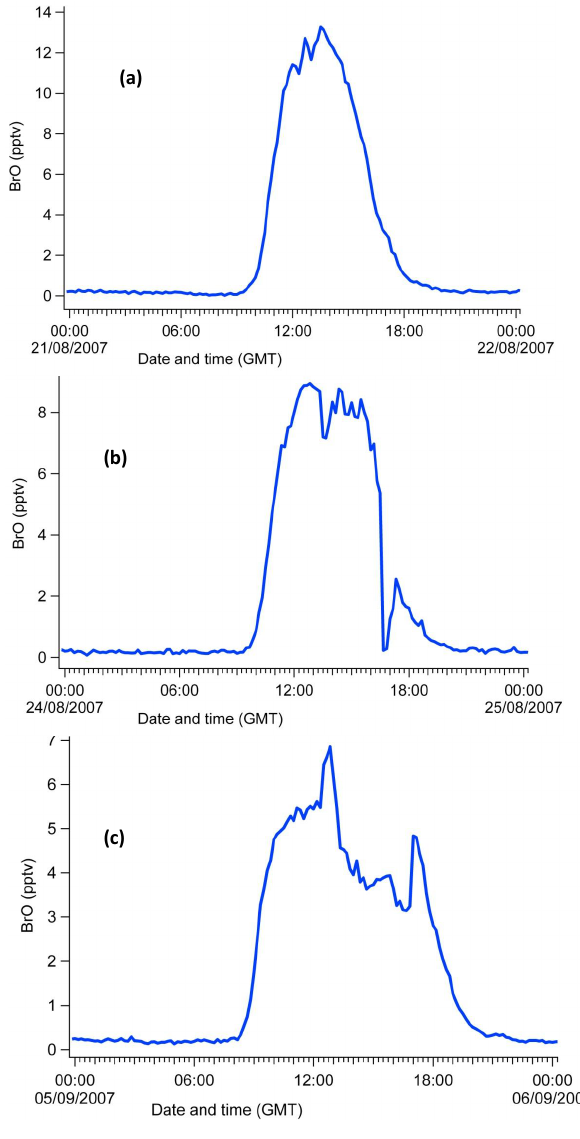
Fig. 5. Plots showing diurnal shape of BrO in pptv with time and date on the x-axis. (a) a single peak around noon; (b) a broad flat- topped maximum also around noon; and (c) double peak with max- ima shortly after sunrise and shortly before sunset.